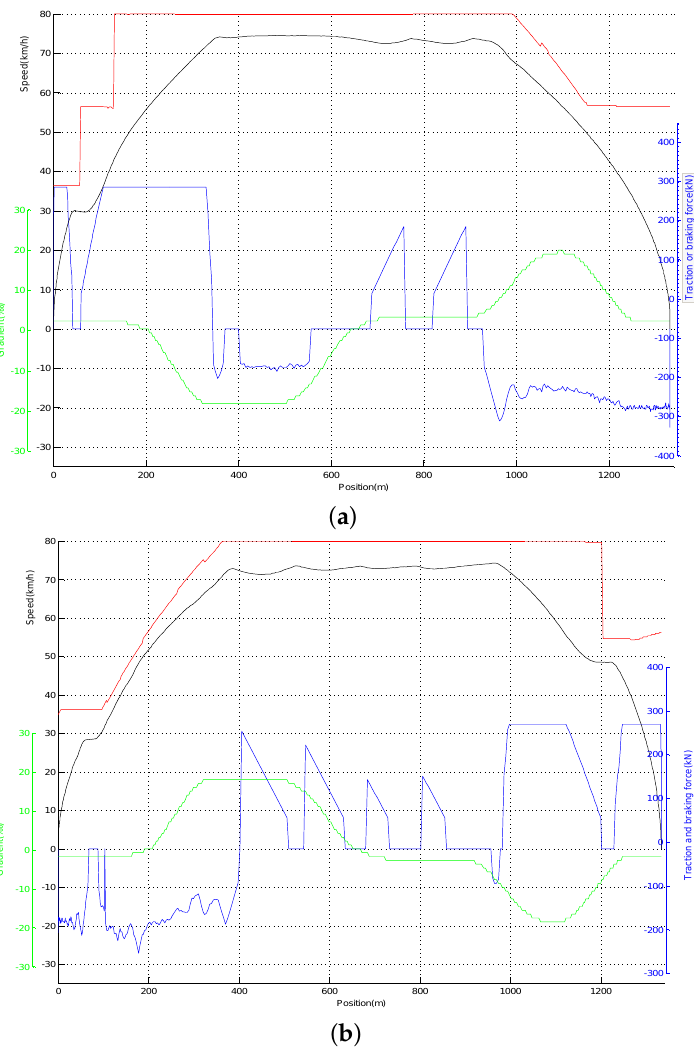
Figure 7. Influence of the gradient length on the energy consumption. ( a ) Driving strategy from Yizhang to Ciqu station; ( b ) driving strategy from Ciqu to Yizhang station.